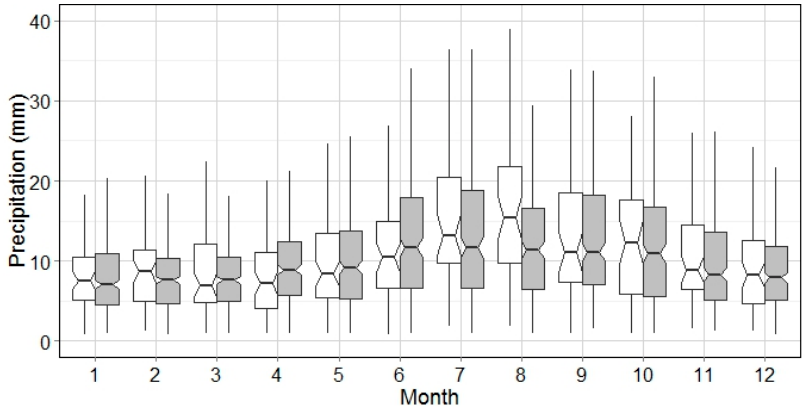
Figure 10. Boxplots of WEP means with WED between 5 and 10 h (Historical: White, Synthetic: Grey).